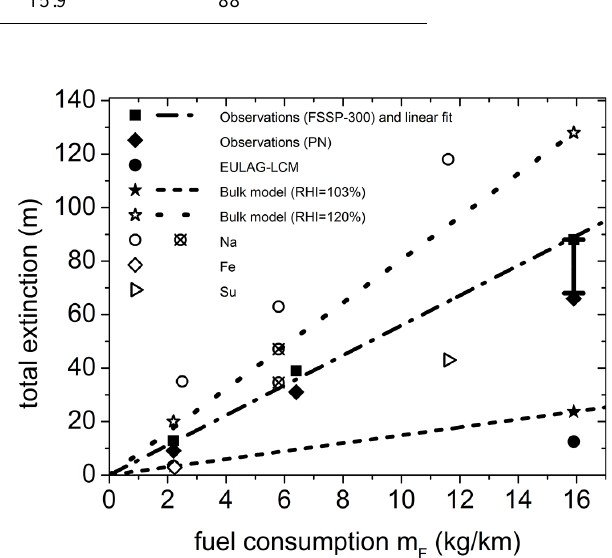
Fig. 9. Total extinction (extinction times contrail cross section) is shown versus the fuel consumption per distance of the contrail- producing airliner. Results from this study are shown in bold sym- bols. A possible overestimation of the total extinction of the A380 contrail due to a focus of measurements in the secondary wake is shown via the error bar. A linear fit has been applied to the FSSP- 300 observations with a gradient of 5.6mkmkg − 1 (point-dashed line). In addition, results from polar nephelometer measurements are shown in bold diamond symbols. Differences between FSSP and PN results are explained by different assumptions of particle shape. The results of the bulk model are shown by the dashed (pointed) line with star symbols fitting the fuel consumption of the analysed airlin- ers for RHI = 103% (120%). For comparison, model results from Naiman et al. (2011) (their Fig. 16) are shown by the empty circle symbols (Na). The contrail age is about 100s, initial RHI are 130% (empty circles) and 110%/120% for the crossed circles, with the lower value for 110%. Lidar observations of a 50s-old contrail of a B747 by Sussmann (1999) are shown by the empty triangle symbol (Su). Additionally, the total extinction observed in situ by Febvre et al. (2009) for a young and small contrail is shown by the empty diamond symbol